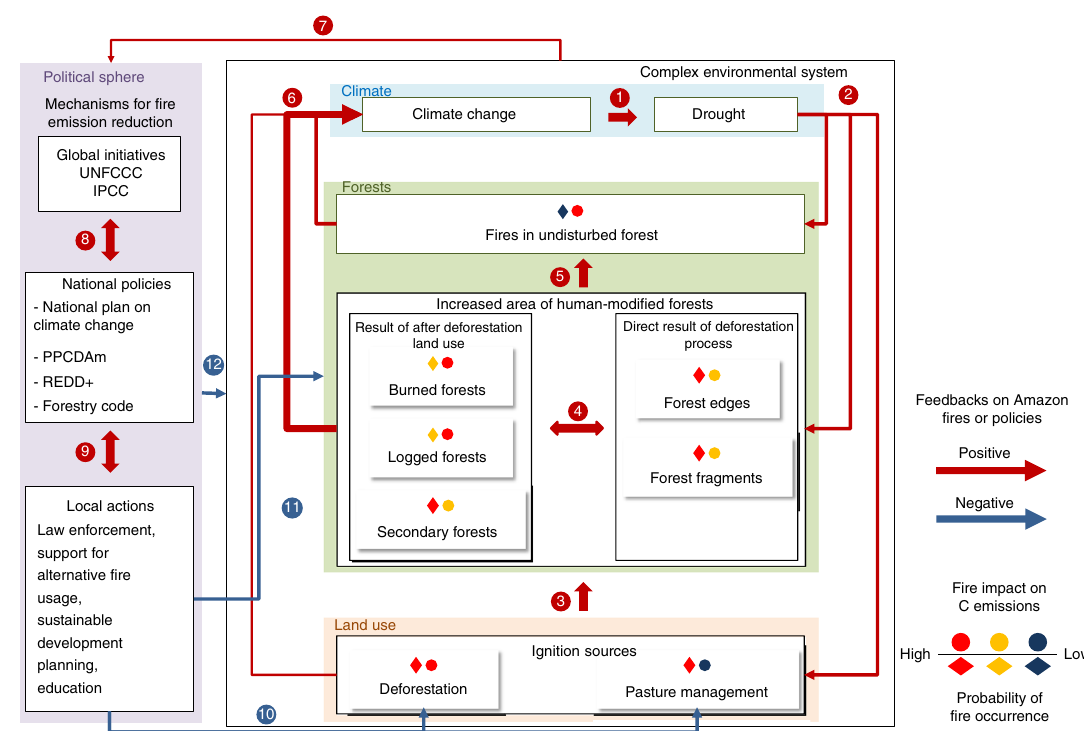
Fig. 8 Conceptual model of feedbacks between climate, land use, forests and policies and their expected impacts on fi re emissions. The system is divided in two large components: the political sphere (purple box) and the complex environmental system. In the political sphere, the mechanisms for fi re emission reduction are divided into three levels of organization from global to local. The complex environmental system is divided in three components: climate (blue box), forests (green box) and land use (light brown box). Positive and negative feedbacks among the components are identi fi ed by red and blue arrows, respectively. The resulting effects of these feedbacks are described by coloured diamonds for the expected probability of fi re occurrence and circles for the potential fi re impact on C emissions. Numbers are displayed to assist with the description of the processes depicted in the main